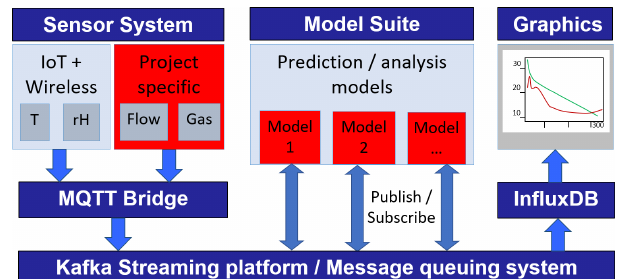
Figure 3. Digital twin platform